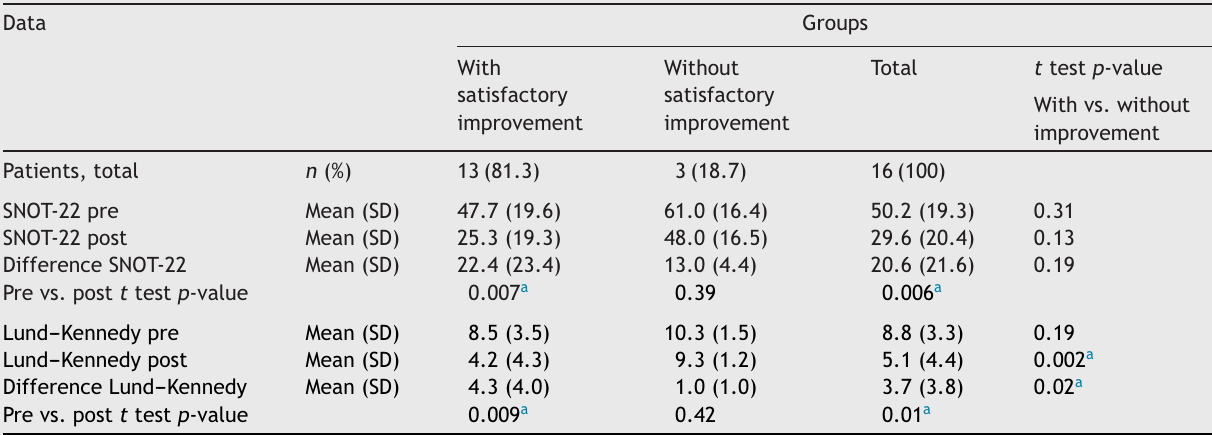
Quantitative assessment of objective